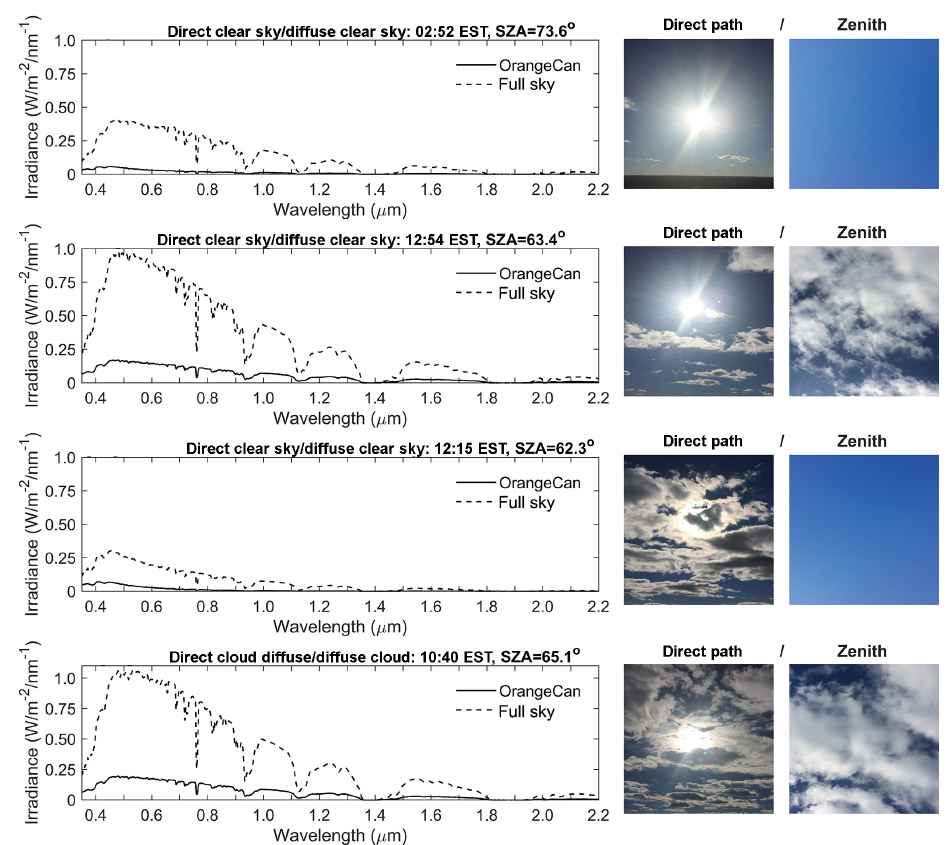
Figure 6. Remote cosine receptor field experiment results from 15 December 2015. Four separate solar illumination scenarios are represented with coincident hemispherical-sky and OrangeCan-sky spectral irradiance measurements. Average spectral irradiance for each scenario was calculated using 1s measurement sampling for local time and solar zenith angle (SZA) shown. Solar illumination conditions along the directly transmitted path and zenith diffuse-sky are shown on the right with photographs. Note: the amount of irradiance is dependent on the temporal proximity to solar noon, which on 15 December 2015 was